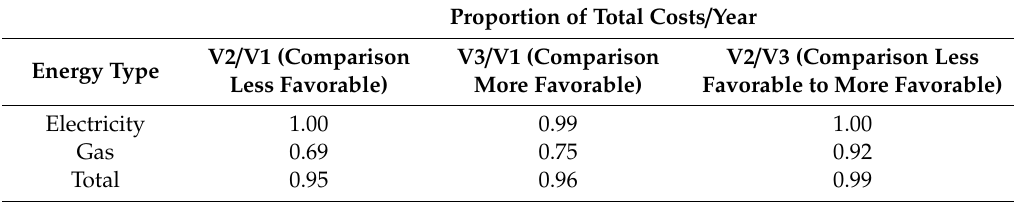
Table 5. Comparison between the three variants of operating costs (adapted from Maire 2011, p. 125).